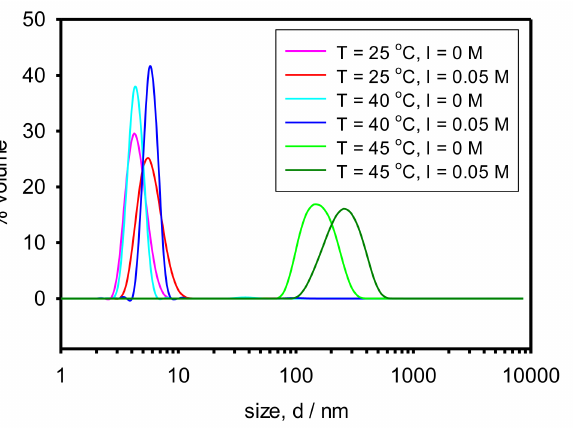
Figure 3. Size distribution by volume of Cop-48/6 for varying temperature and ionic